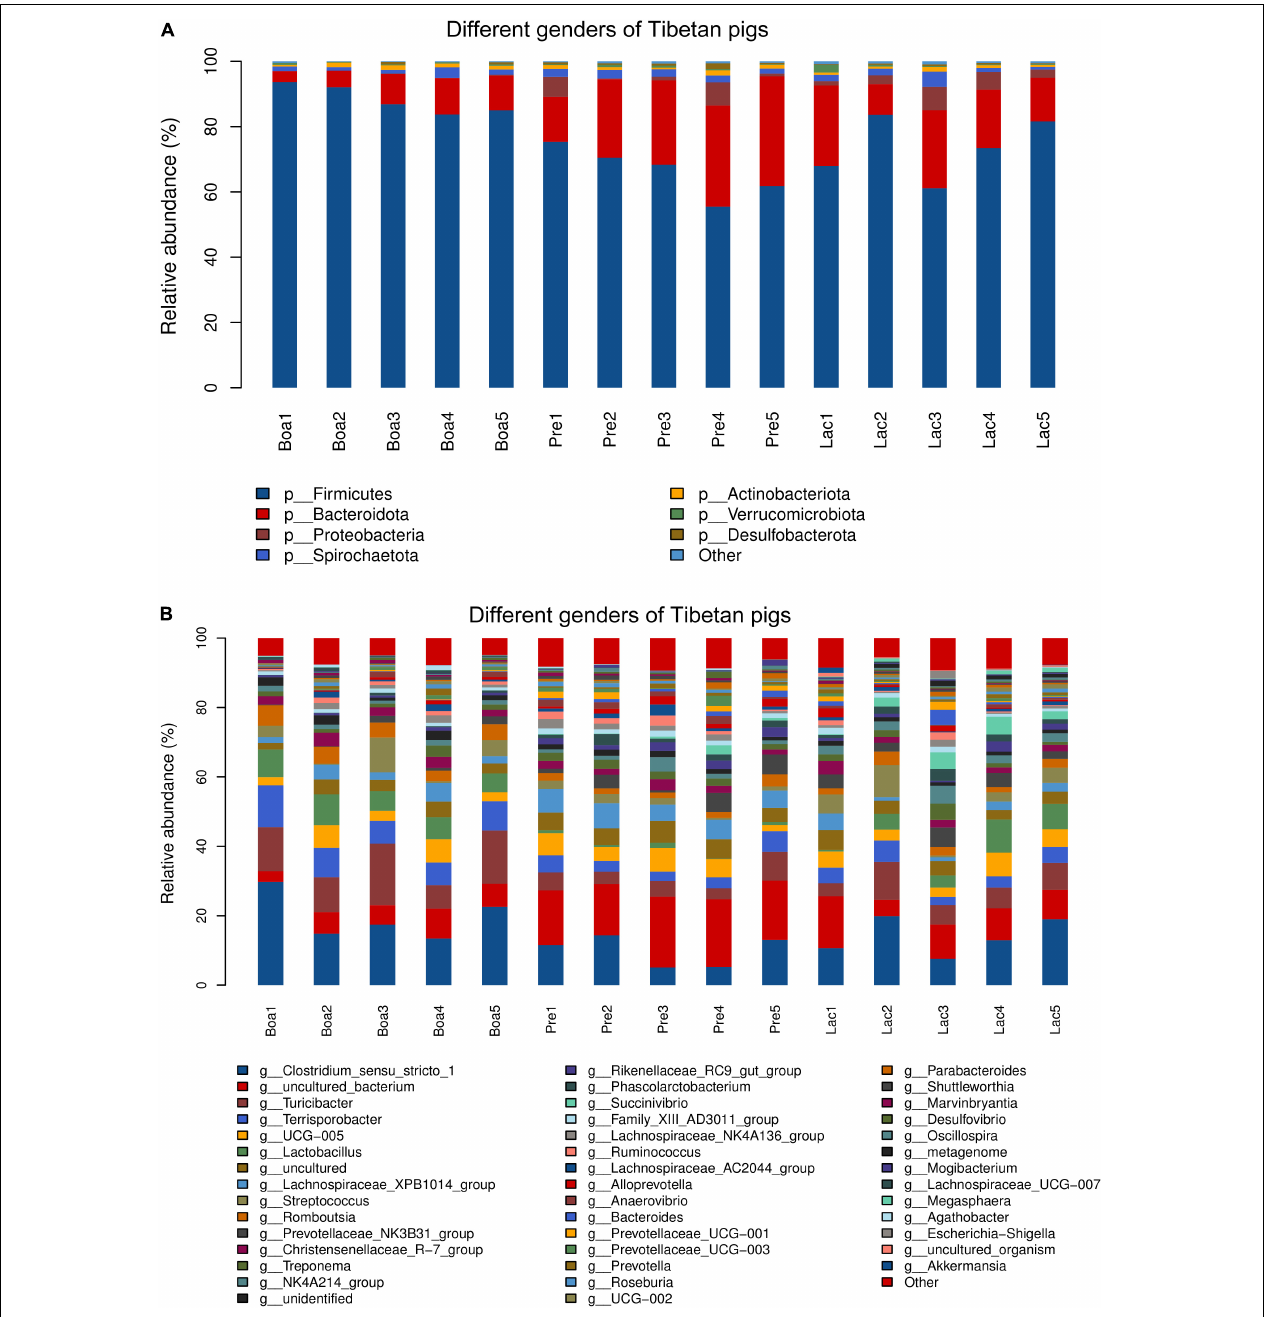
FIGURE 8 | Relative abundance of bacterial species residing in the guts of boars, pregnant sows, and lactating sows. At the phylum level (A) and at the genus level (B) .